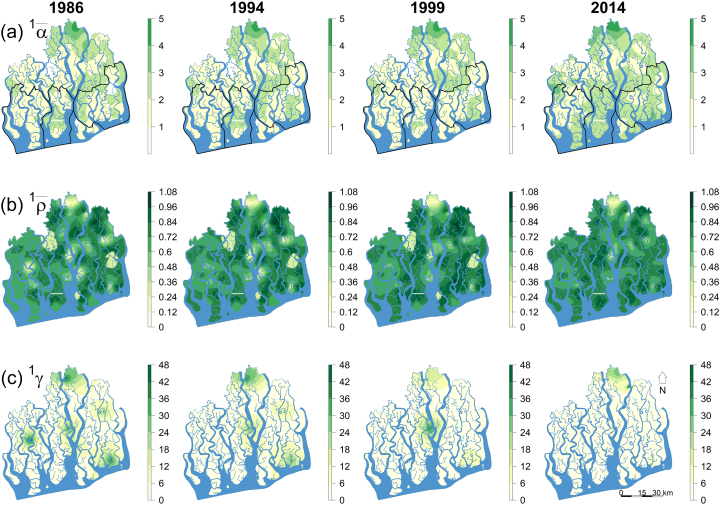
Spatial distributions of subcommunity alpha, beta and gamma diversities (for q = 1) over the entire Sundarbans generated through ordinary kriging. Higher values of α¯ and γ indicate greater species diversity and community contribution to the overall diversity of the ecosystem. Lower values of ρ¯ indicate greater heterogeneity in species composition (i.e. community distinctness from the metacommunity) and higher values of ρ¯ represent greater representativeness (i.e. homogeneity) in species composition. The black contours represent the three protected areas.